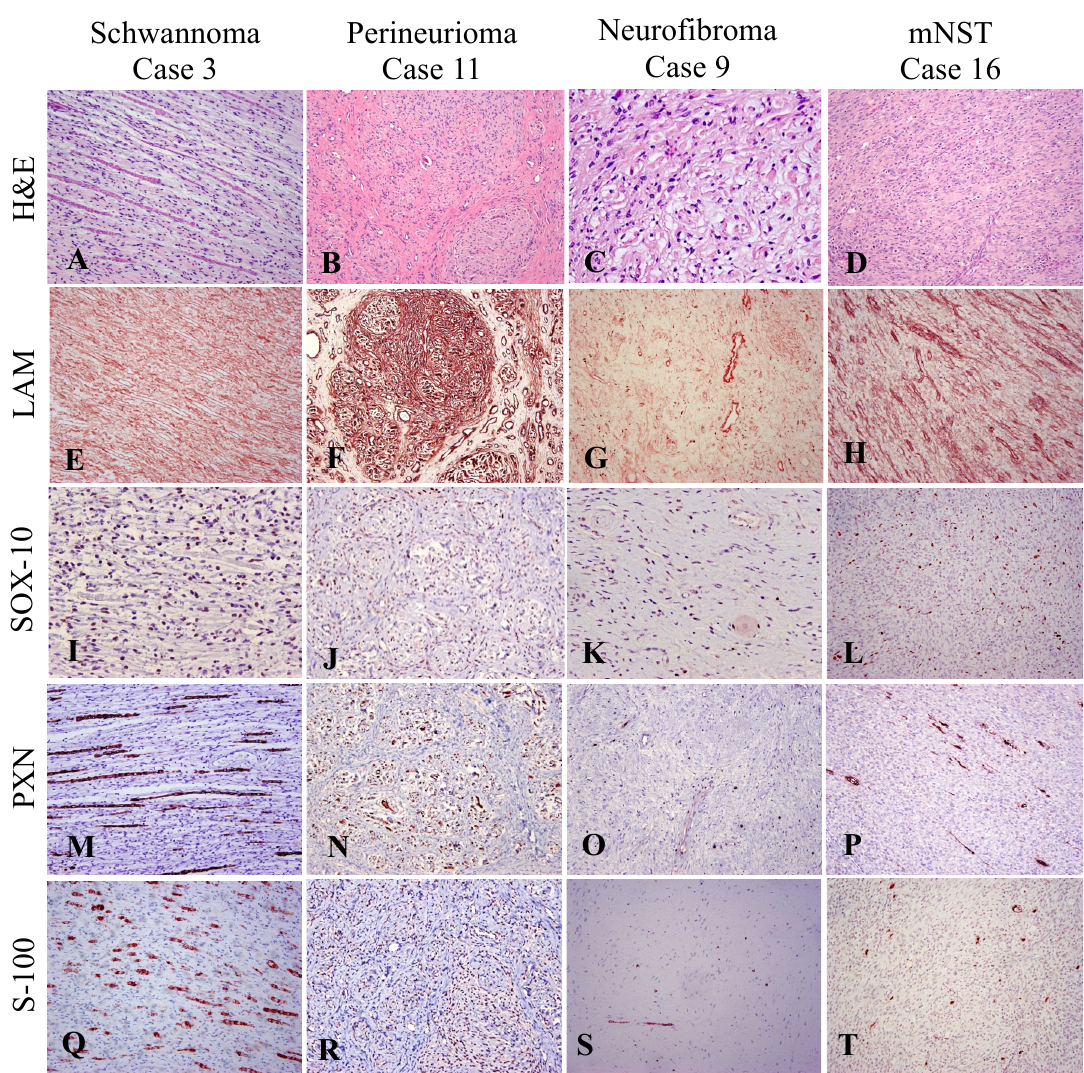
Figure 2. Peripheral nerve IHC panel phenotype benign and malignant peripheral nerve sheath tumors (NST). The nerve markers to be tested in NST included laminin (LAM), Sox-10, periaxin-1 (PXN) and S-100. ( A – D ) H&E of each NST sub-type is given for histomorphological context. In all NST, LAM provided robust results by variably highlighting the cytoplasmic membrane of Schwann cells and of perineurial cells ( E – H ). Sox-10 was consistent in identifying nuclei from neoplastic Schwann cells and those entrapped within nerve fibers. ( I , J ) Schwannoma and pe- rineurioma tumors had the highest scores for Sox-10, whereas neurofibromas ( K ) and mNST ( L ) show intermediate and low scores. ( M – T ) PXN, like S-100, strongly labeled fragmented myelinated fibers entrapped within tumors. In perineuriomas, they labeled myelin surrounding intact axons.